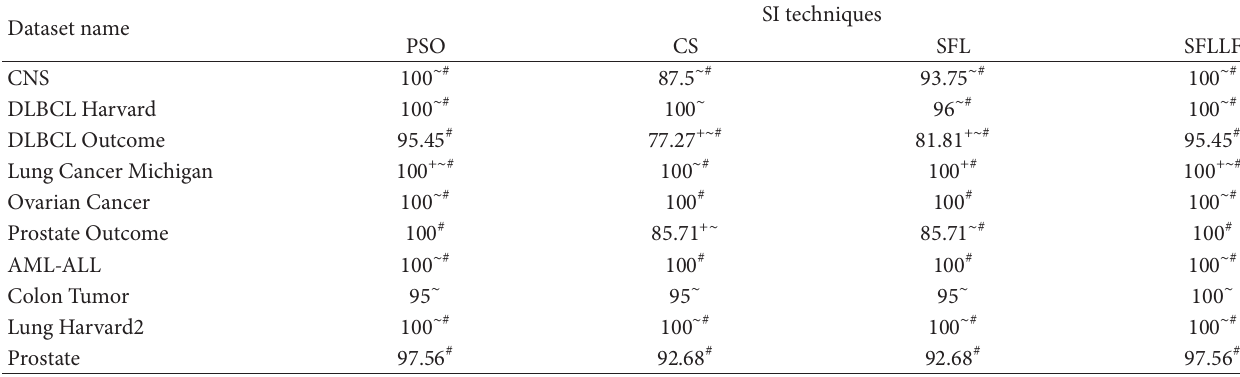
Table 3: Comparison of classification accuracies obtained from different SI techniques.